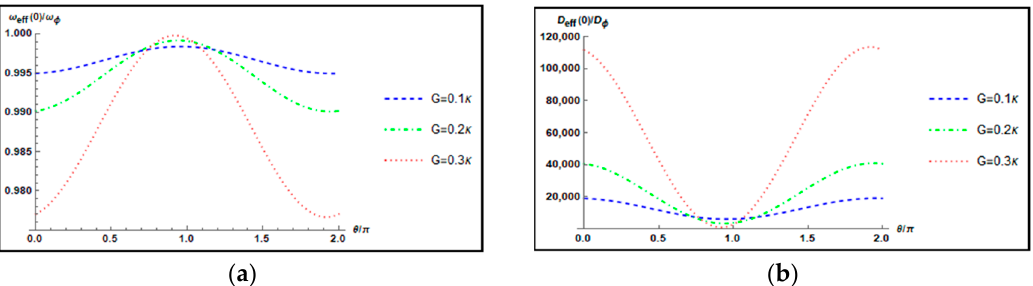
Figure 3. Plot of ( a ) the normalized effective resonance frequency ω ef f ( 0 ) / ω φ and ( b ) the normalized effective damping rate D ef f ( 0 ) / D φ of the mechanical torsional pendulum versus the parametric phase θ / π for different parametric gains G = 0.1 κ ,0.2 κ ,0.3 κ when ∆ = ω φ , ω = 0, and l =